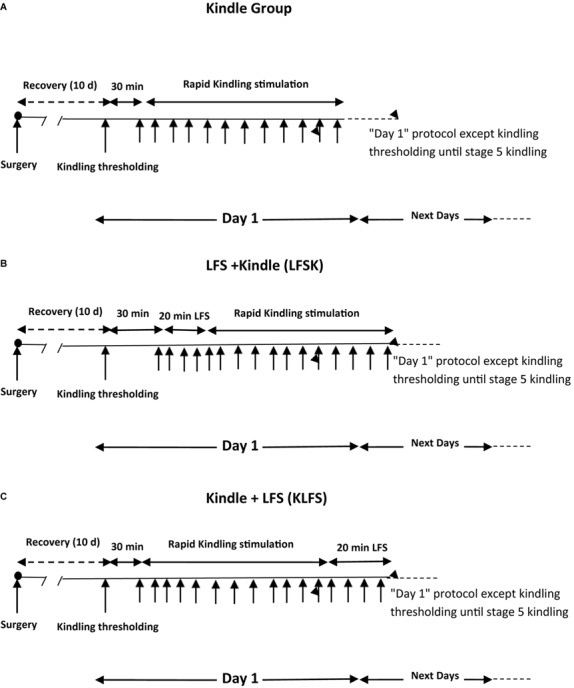
Schematic diagram of experimental groups. (A) Kindle group. (B) LFS + kindle (LFSK) group, (C) kindle + LFS (KLFS) group.